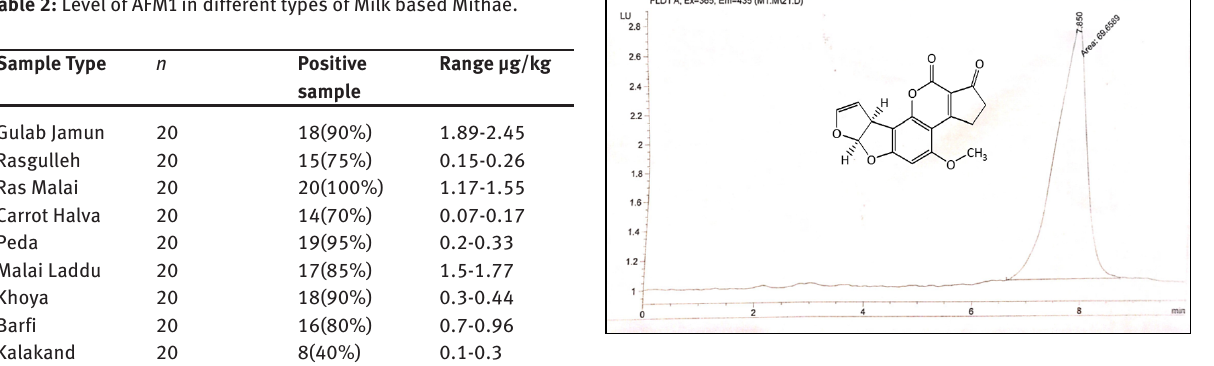
Figure 1: HPLC Chromatogram of standard solution of A.